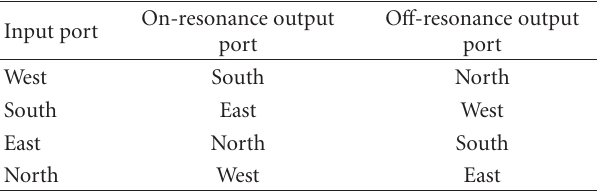
Figure 4: Comparisons between the spectral response of the Drop Path (Port 1 (cid:3) to Port 2 (cid:3) ) of the passive 1 × 2 PSE, calculated via 2D-FDTD and by means of the s -matrix model. Table 1: Available routing paths inside the 4 × 4 optical